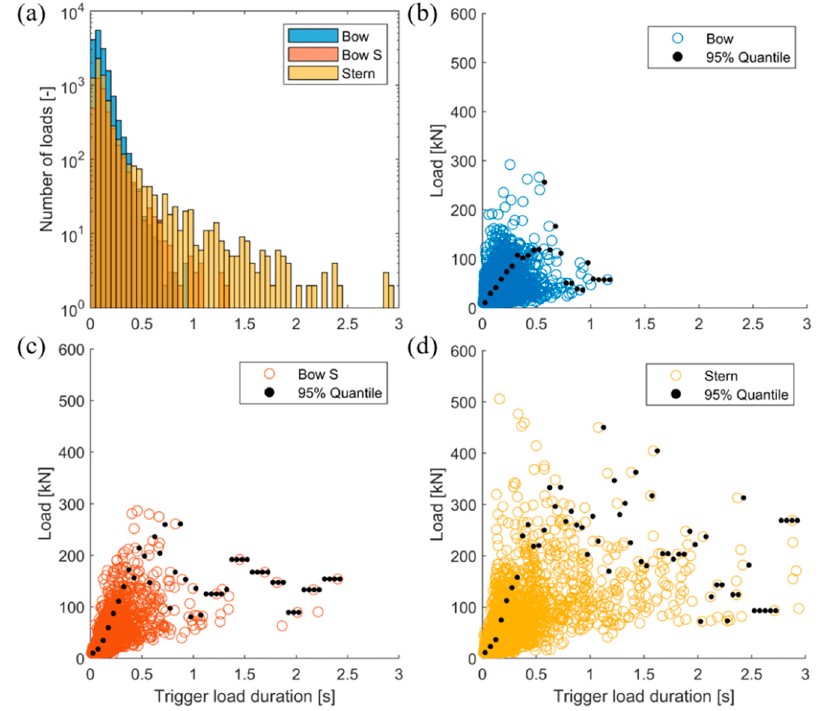
Figure 14. Duration of load events from all the tests at ( a ) all hull regions in histogram format, and individual loads with calculated 95% quantiles at ( b ) bow, ( c ) bow shoulder, and ( d ) stern shoulder.